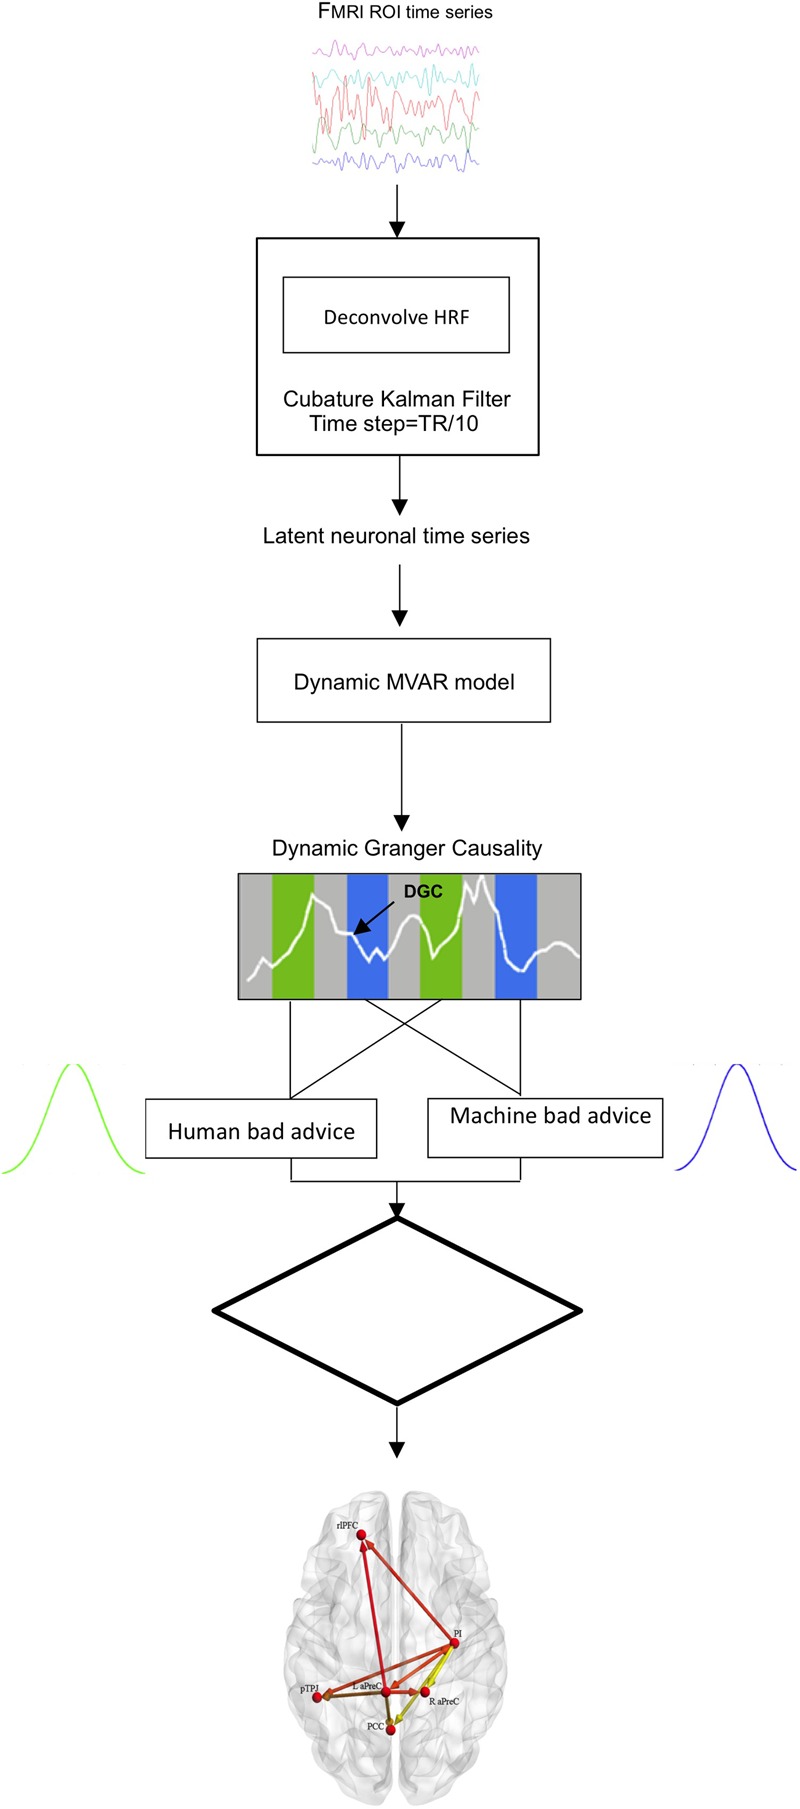
Schematic illustrating the effective connectivity analysis pipeline.